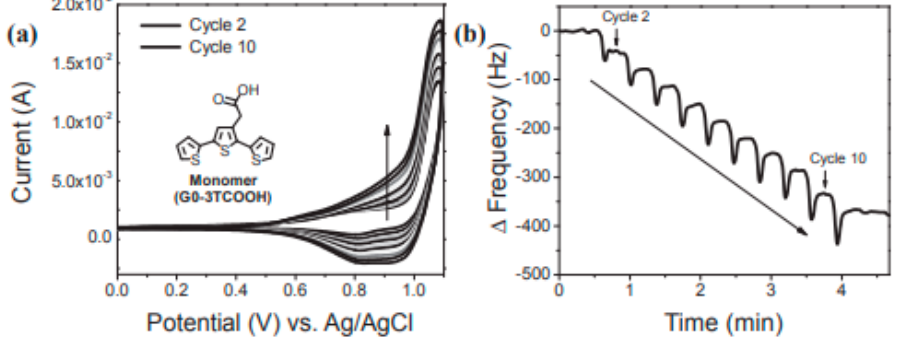
Figure 5. EC-QCM in situ measurements of the CV electrodeposition of the MIP film onto PS- (500 nm size) templated Au surface: ( a ) CV diagram and ( b ) QCM response. Reprinted with permission from reference [58]. Copyright 2012 Wiley.